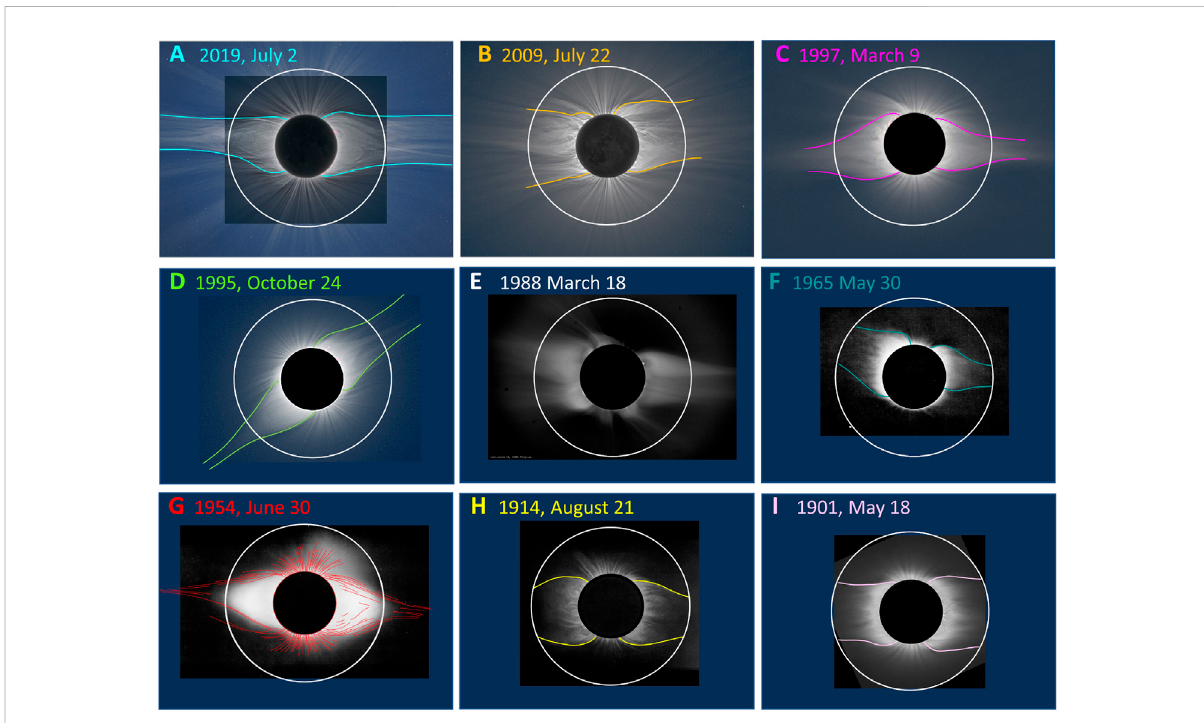
FIGURE 1 Photographic observations of total solar eclipses near sunspot minimum over the past 120 years. On each image has been added the nominal solar source surface at heliocentric distance r = 2.5 R ⊙ and the estimated boundaries of the streamer belt on both the east and west limbs of the Sun. Ineachevent, theheliocentric angular widthsofthestreamerbelts,as seenfrom Earth, ontheEastandWest limbs ( Λ E and Λ W ,respectively)arethen scaled from these estimated edges at r = 2.5 R ⊙ and a mean streamer belt width computed Λ SB = ( Λ E + Λ W )/2. Events are: (A) 2 July 1991 (5 months before the sunspot minimum between cycles 24 and 25), image from Tres Cruses, Chile by Peter Aniol (PA), processed by Miloslav Druckmüller (MD) (Druckmüller et al., 2006); (B) 22 July 2009 (7 months after minimum 23/24), image from Enewetak Atoll, Marshall Islands by PA, MD, Vojtech Ru š in (VR), Ľ ubomír Klocok, Karel Marti š ek, and Martin Dietzel, processed by MD; (C) 9 March 1997 (8 months after minimum 22/23), image from Yerofei Pavlovich, Siberia, Russia by Úpice observatory, processed by MD; (D) 24 October 1995 (10 months before minimum 22/23), image from Neem Ka Thana, Rajasthan, India by VR, processed by MD; (E) 18 March 1988 (18 months after minimum 21/22), image from the Philippines by the High Altitude Observatory; (F) 30 May 1965 (7 months after minimum 19/20) image from a NASA aircraft over Canada by Sturrock andSmith(1968)(seealsosketchbyWaldmeier (1966)); (G) 30June1954(2 monthsafterminimum18/19)imagefromSydKosterIsland,Sweden,by Gold (1955) overlaid with sketch by Waldmeier (1955); (H) 21 August 1914 (14 months after minimum 14/15) image from Minsk, Russia by H.S. Jones and C.R. Davidson processed by A. Crommelin (Dyson, 1927); (I) 18 May 1901 (7 months before minimum 13/14) image from Pamplemousses, Mauritius by Edward Maunder and Annie Maunder, processed by William Henry Wesley (Dyson, 1927). For the last two events the image processing used was to make drawings from several large photographic plates. Note that the 18 March 1988 event (E) is the furthest removed from sunspot minimum and there is no clear distinction between a single streamer belt and two clear polar coronal holes: hence this event is not included in the survey of sunspot minimum